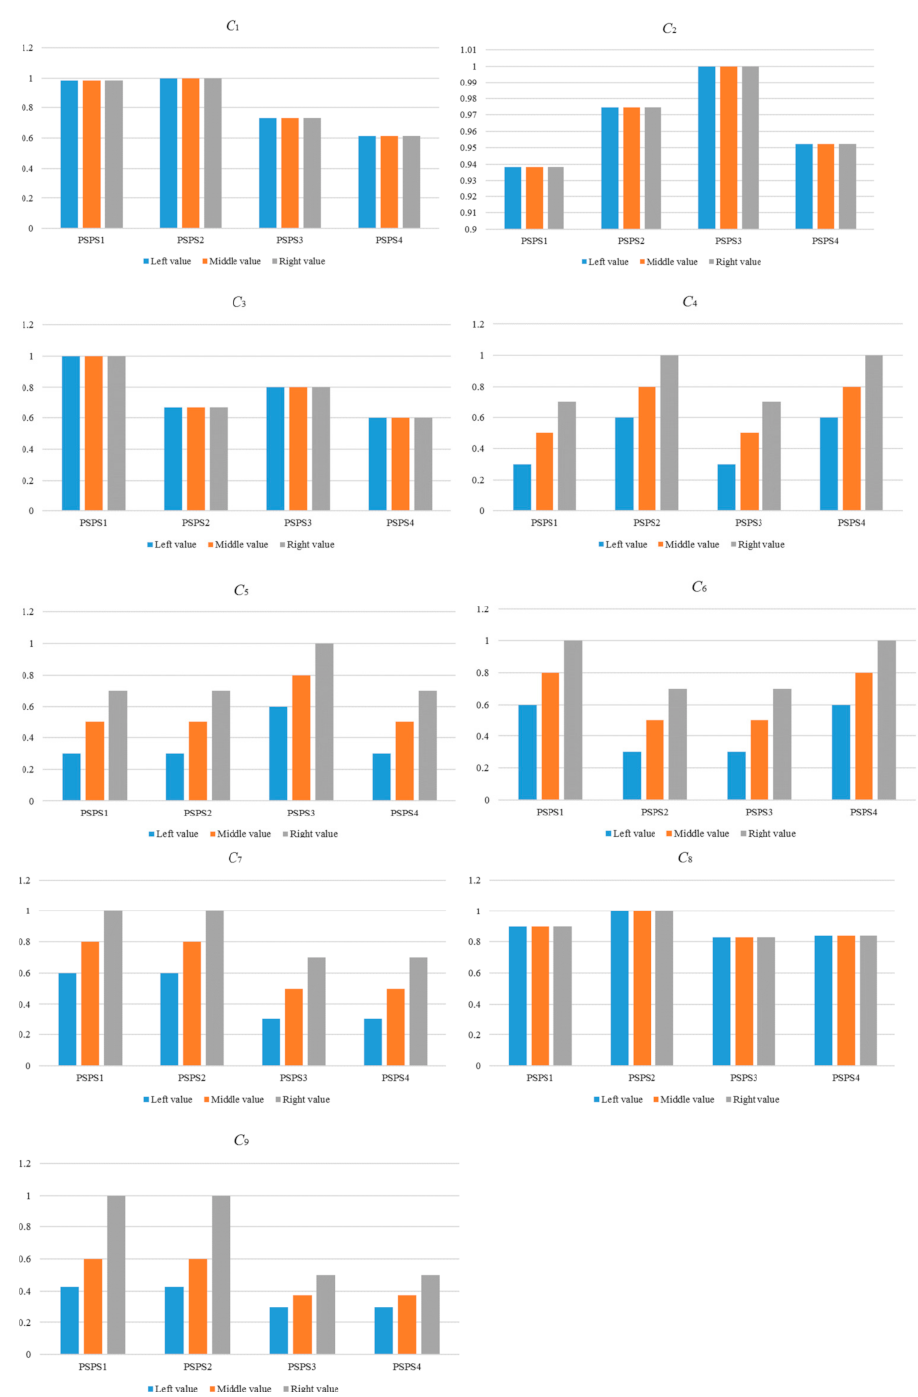
Figure 5. The fuzzy normalized performances of nine sub-criteria of four pumped storage power